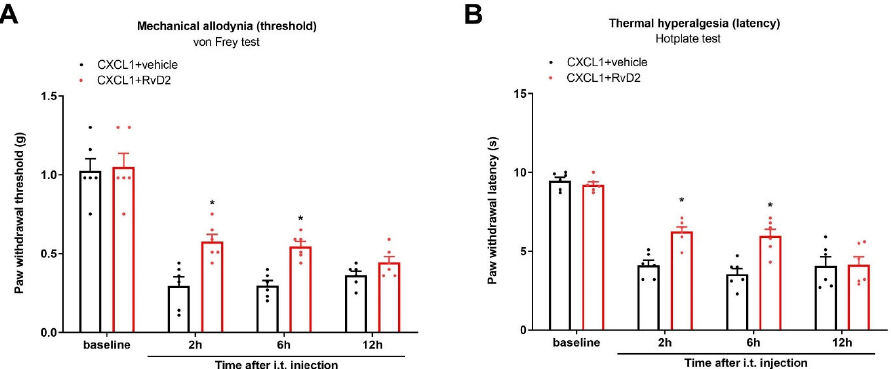
Figure 7. Generation of acute pain by CXCL1 exposure was reduced after co-administration of RvD2. RvD2 (i.t., 500 ng) was administered 1 h prior to recombinant CXCL1 application (i.t., 100 ng). Mechanical allodynia was evaluated by measuring paw withdrawal threshold ( A ) using von Frey experiments, and thermal hyperalgesia was evaluated by measuring paw withdrawal latency ( B ) using hotplate experiments. Exogenous CXCL1-caused acute nociceptive phenotypes were ameliorated by co-application of RvD2. Results are presented as the mean ± SEM ( n = 6) and compared using two- way ANOVA followed by Bonferroni multiple comparisons. * p < 0.05 vs. group CXCL1 + vehicle. i.t. = intrathecal